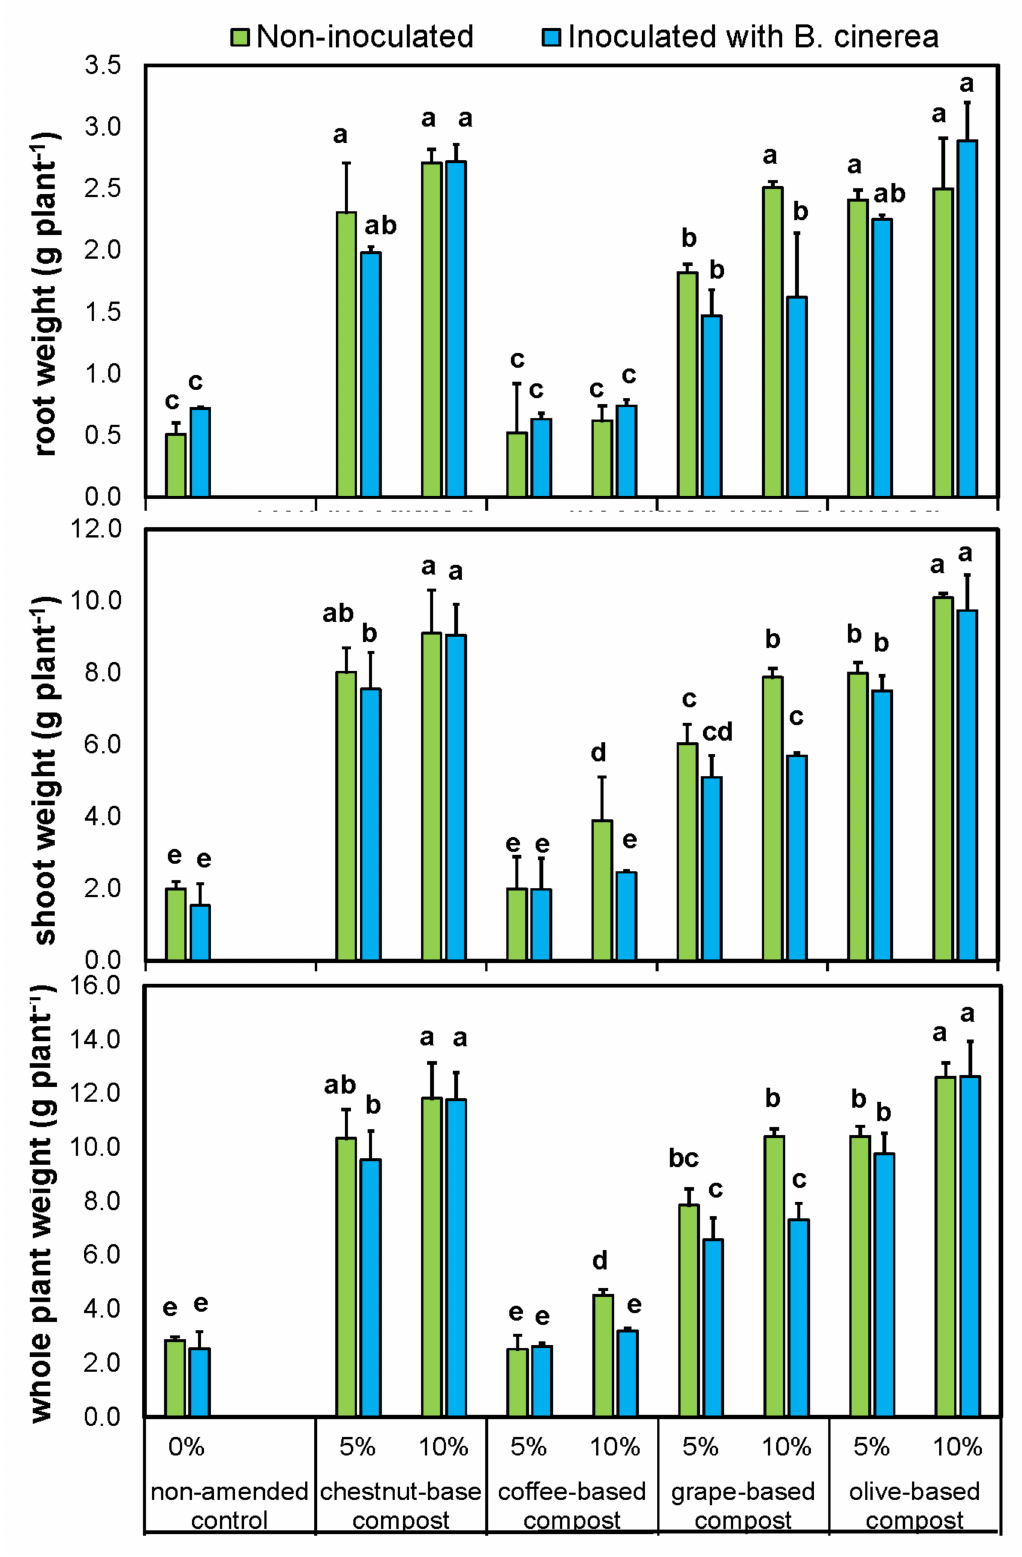
Figure 3. Shoot and root yields (dry weight basis) of lettuce plants grown on soil/compost mixes inoculated with B. cinerea . The composts were incorporated into soils at proportions of 5% and 10% (weight basis). Control treatments consisted of non-amended soils. Different letters above the bars indicate significant differences among means ( p < 0.05; ANOVA/Tukey’s